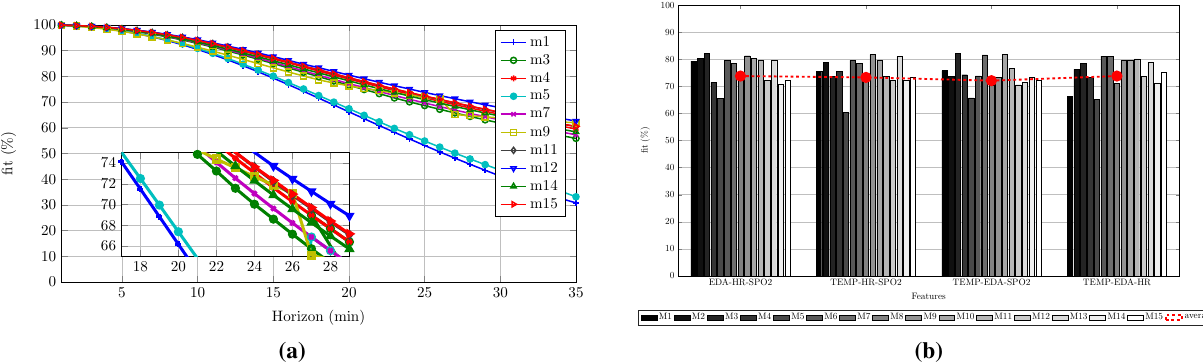
Figure 6. Validation applying the average model, and training for triads of features for Patient A. ( a ) Average model with M models applied over the remaining 10 migraines; best ( b ) Fitness comparison for N4SID and different three-features combinations in the training stage.